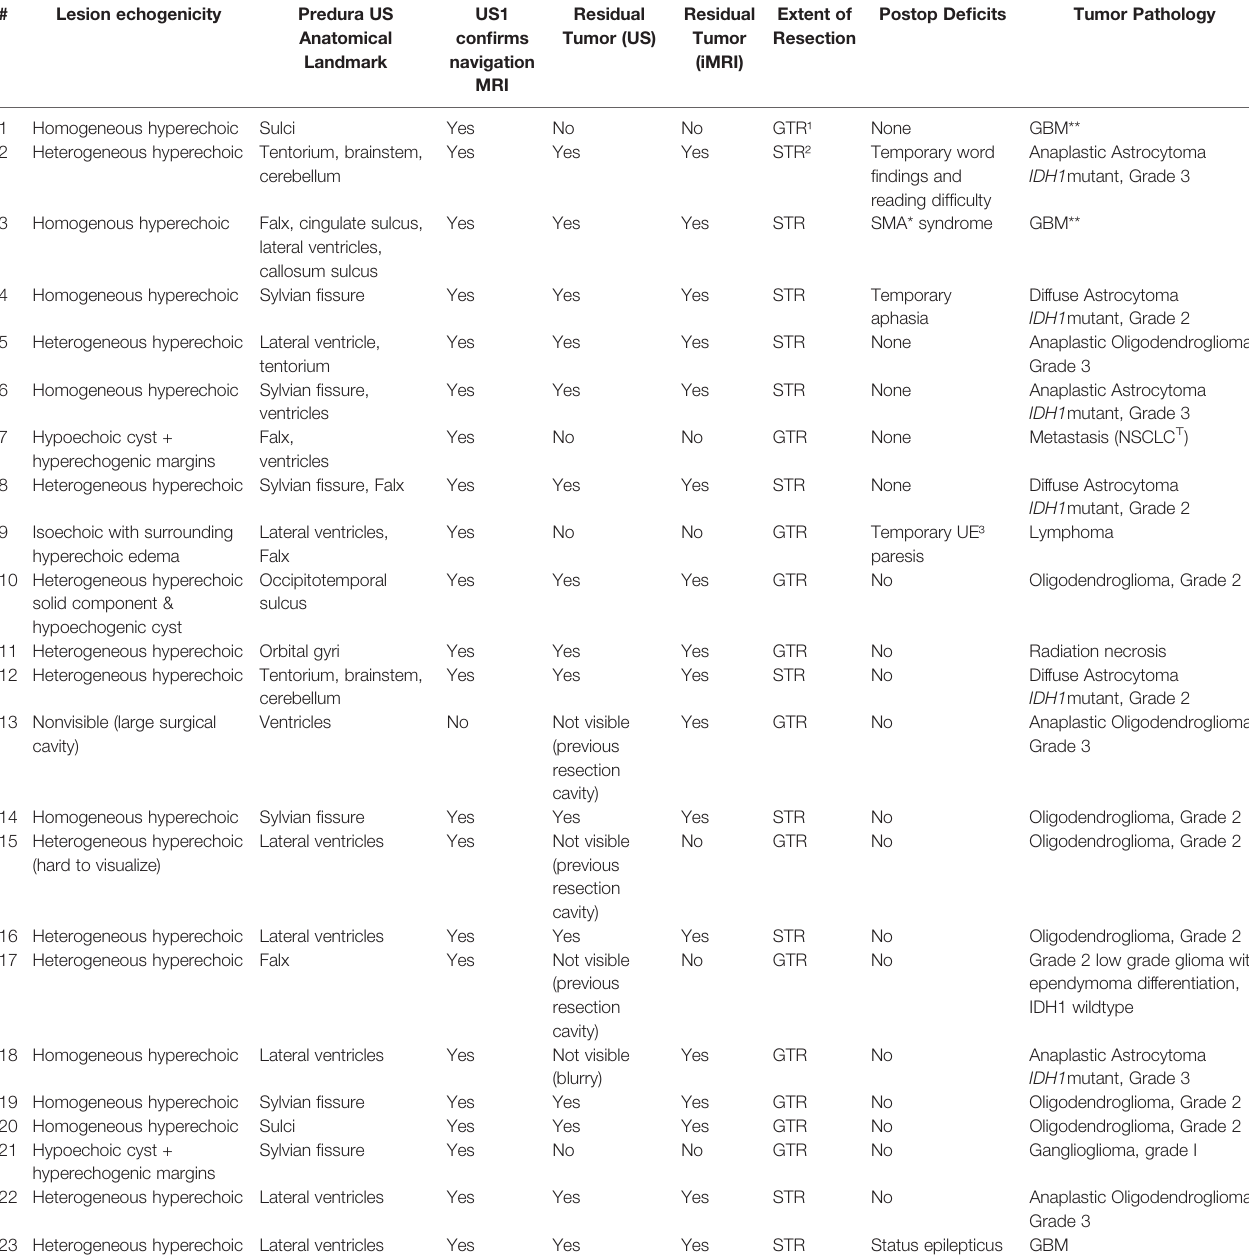
TABLE 2 | Summary of Intraoperative and Postoperative Imaging Findings.